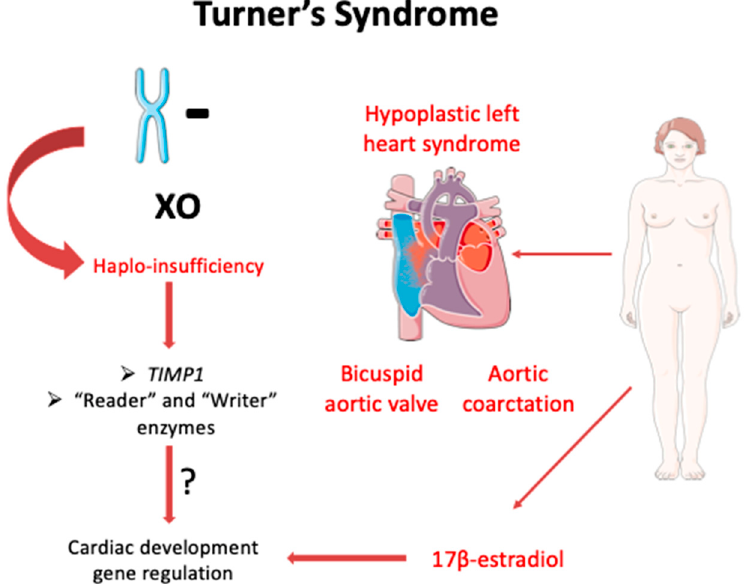
Figure 1. Complete or partial loss of one X chromosome in TS is associated with cardiac abnormalities. These dysfunctions vary, with hypoplastic left heart syndrome being the most common among patients with TS. Multiple factors related to the missing X chromosome have been associated with the TS phenotype. Haplo-insufficiency of TIMP1, “reader” and “writer” enzymes, and abnormalities in 17 β -estradiol production are only part of a general genetic and hormonal instability observed in patients with TS. Figures were produced using Servier medical art.